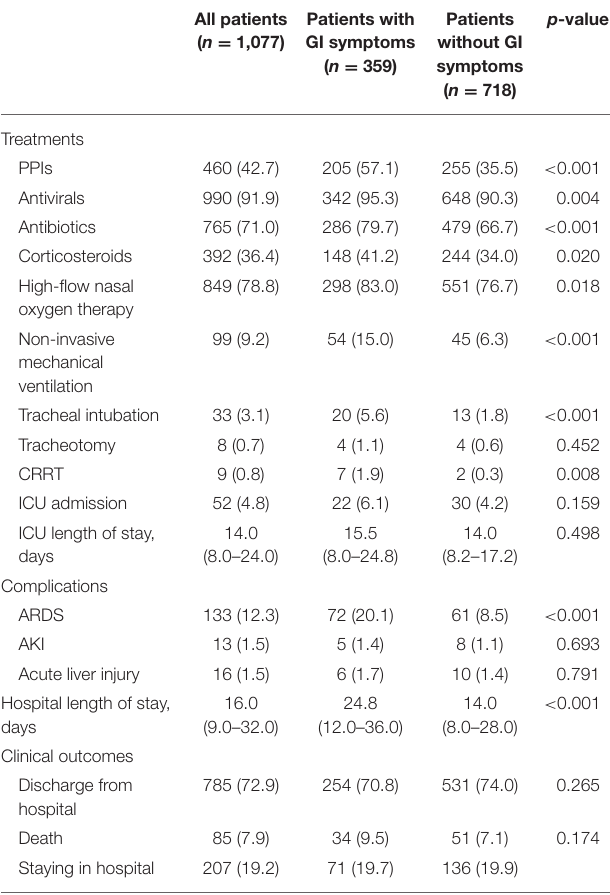
TABLE 4 | Treatment, complications and clinical outcomes of patients with COVID-19 with or without GI symptoms.